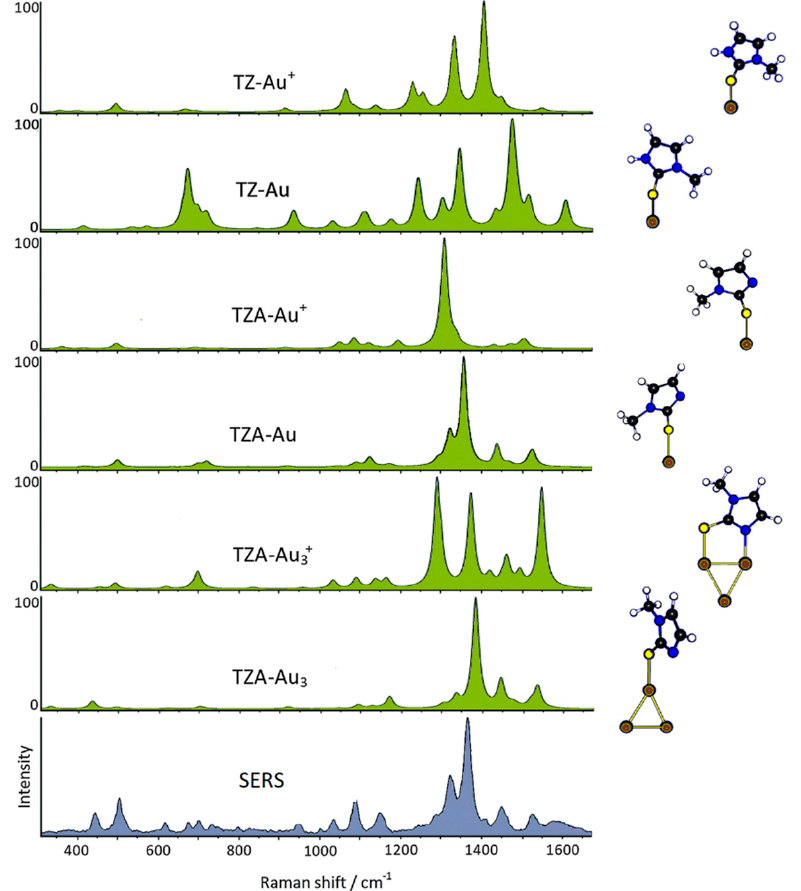
Figure 3. DFT-simulated Raman spectra of tapazole–gold complexes compared with the observed SERS spectrum of tapazole adsorbed on gold colloidal nanoparticles (647.1 nm laser excitation).